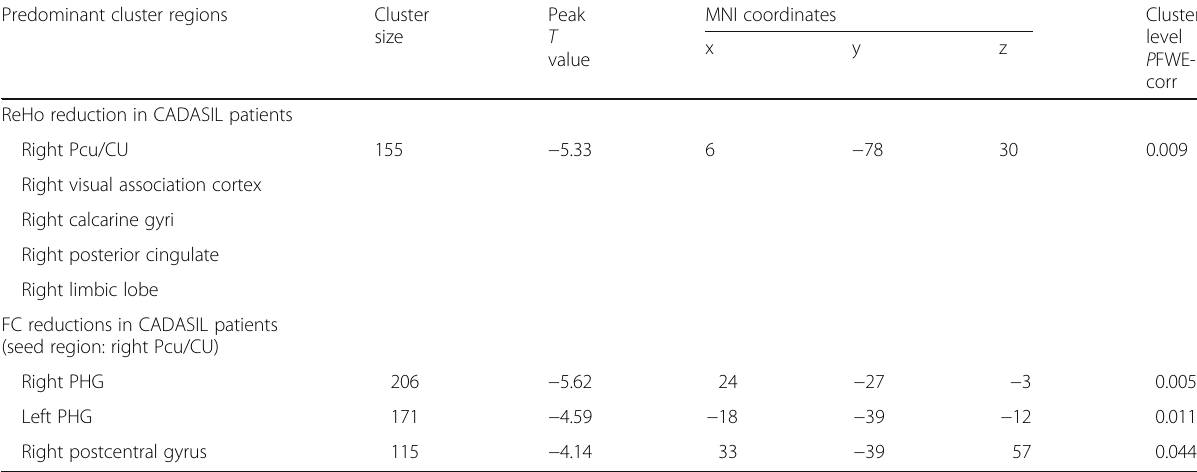
level P FWE- corrx y z